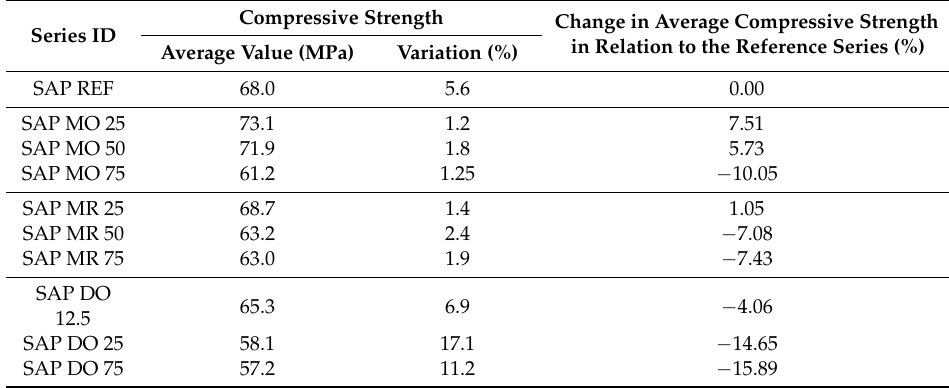
Table 7. Average compressive strength of the tested compositions of concrete composites and the difference between superabsorbent polymers (SAP) modified concrete series and reference series.